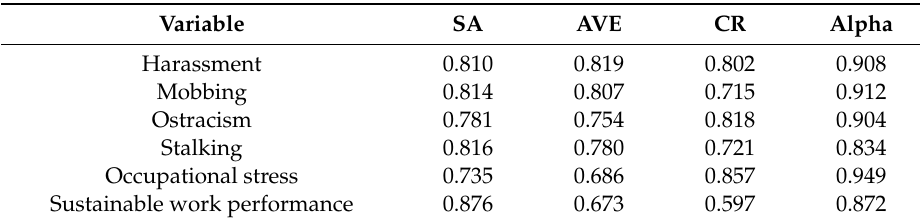
Table 2. Construct reliability and